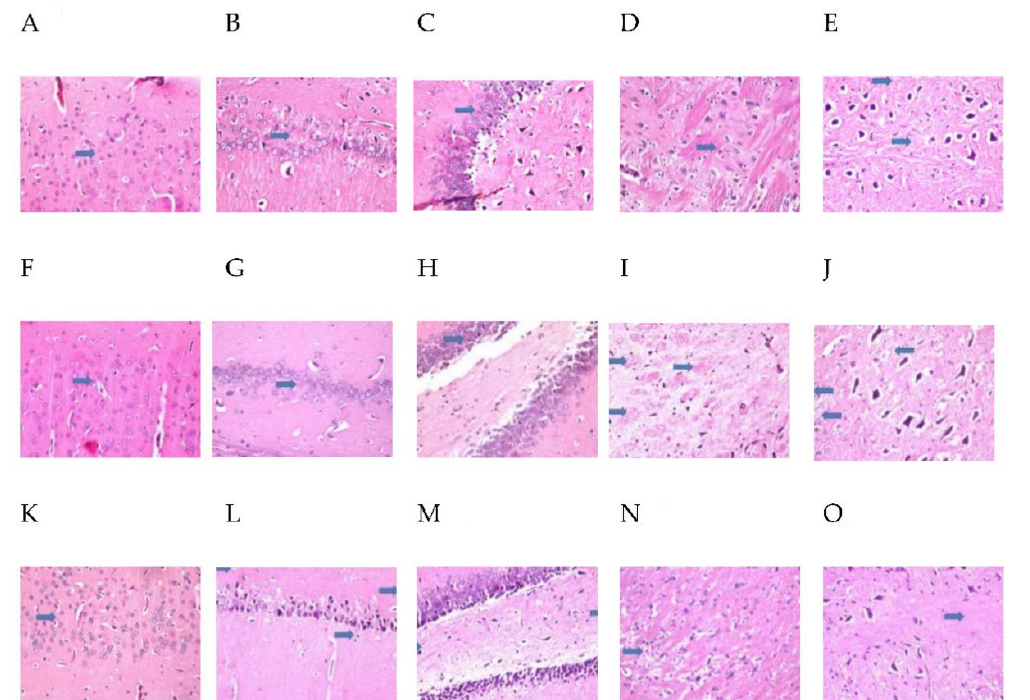
Figure 12. Photomicrographs ( A – E ): transverse brain tissue sections from MH treated-PM animals show no histopathological alteration in cerebral cortex ( A ) (arrows), hippocampus (subiculum, fascia dentate and hilus) ( B , C ) (arrows), striatum and substantia nigra ( D , E ) (arrows). Photomicrographs ( F – J ): Transverse brain tissue sections from MH + MSG of NF animals illustrate normal histological structure of the cerebral cortex and hippocampus (subiculum, fascia dentate and hilus) ( F – H ) (arrows). Focal fine plagues were detected in striatum ( I ) (arrows) and there was atrophy seen in some neuronal cells in the substantia nigra ( J ). Photomicrographs ( K – O ): Transverse brain tissue sections from MH + MSG in PM fed animals display no histopathological alteration in the cerebral cortex ( K ) (arrows). Nuclear pyknosis and degeneration were observed in some neuronal cells of the subiculum as well as the fascia dentate in the hippocampus ( L , M ) (arrows). The striatum showed intracellular oedema in the neuronal cells ( N ) (arrows). Mild atrophy was detected in the cells of substantia nigra ( O ) (arrows). Magnification was 40 ×